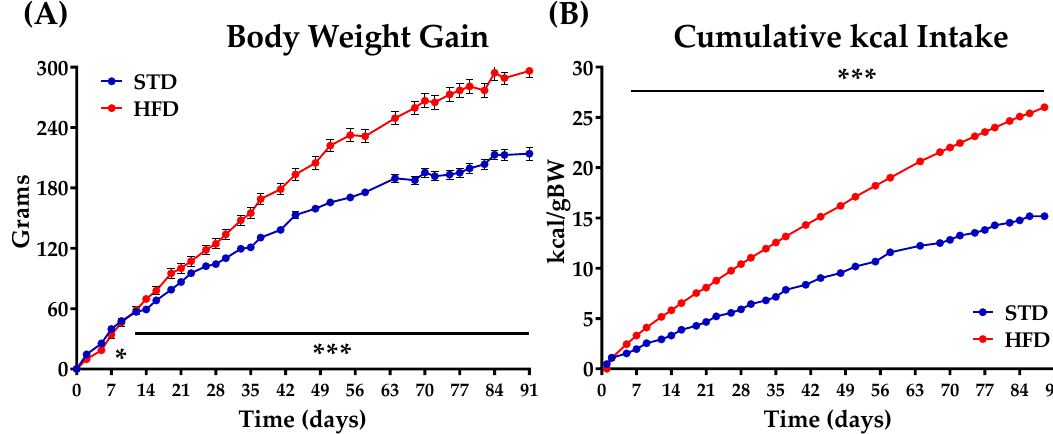
Figure 3. Body weight gain ( A ) and cumulative kcal intake ( B ) in animals fed for 91 days (13 weeks) with either a standard diet chow (STD) or a hypercaloric cafeteria diet (HFD). Values are expressed as mean ± standard error of the mean (SEM) ( n = 32 animals/group). Two-way ANOVA and Bonferroni post hoc test: (*) p < 0.05 and (***) p < 0.001 vs. STD group.